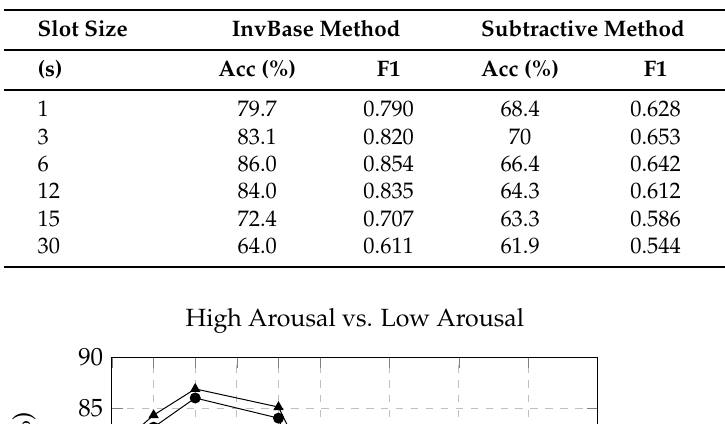
Table 3. Arousal classification accuracies and F1 scores of InvBase, subtractive, and NBC methods using SVM for various slot sizes.